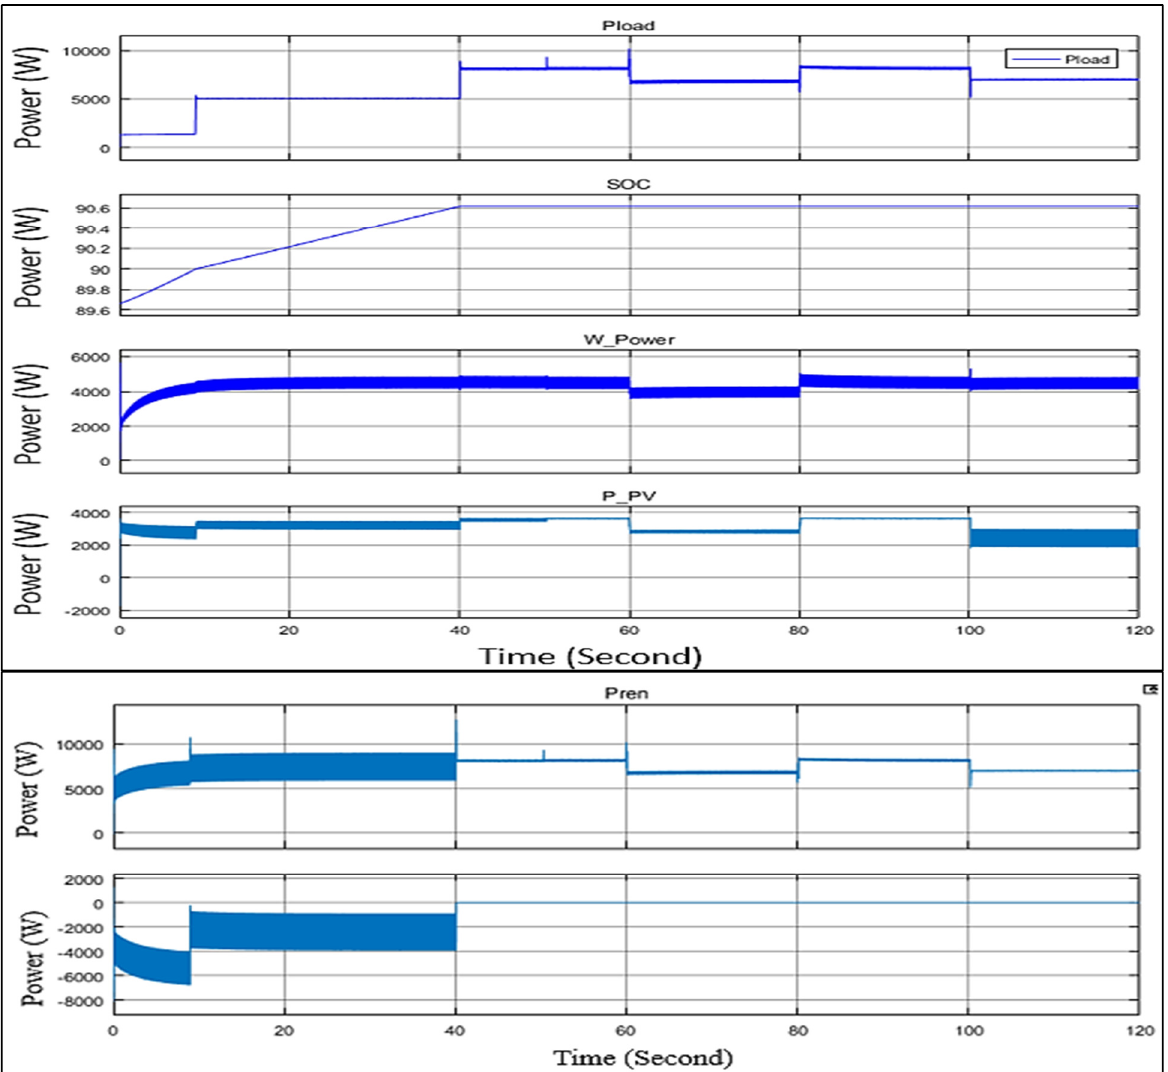
Fig 6: Power Load, SOC of Battery, Wind Power, Photovoltaic Power, Power Generated by Renewable Energy and Battery